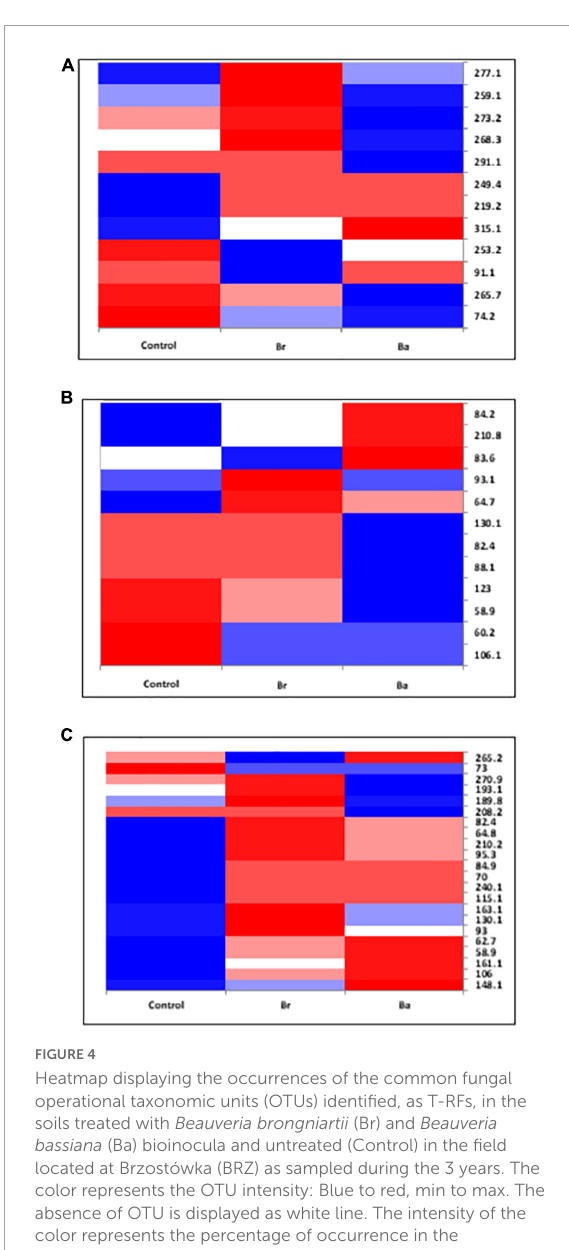
FIGURE3 Heatmap displaying the occurrences of the common fungal operational taxonomic units (OTUs) identified, as T-RFs, in the soils treated with Beauveria brongniartii (Br) and Beauveria bassiana (Ba) bioinocula and untreated (Control) in the field located at Nowa Wola (NOW) as sampled during the 3 years. The color represents the OTU intensity: Blue to red, min to max. The absence of OTU is displayed as white line. The intensity of the color represents the percentage of occurrence in the treatments. Samples were collected in (A) September 2014, (B) June 2015, and (C) September 2015.